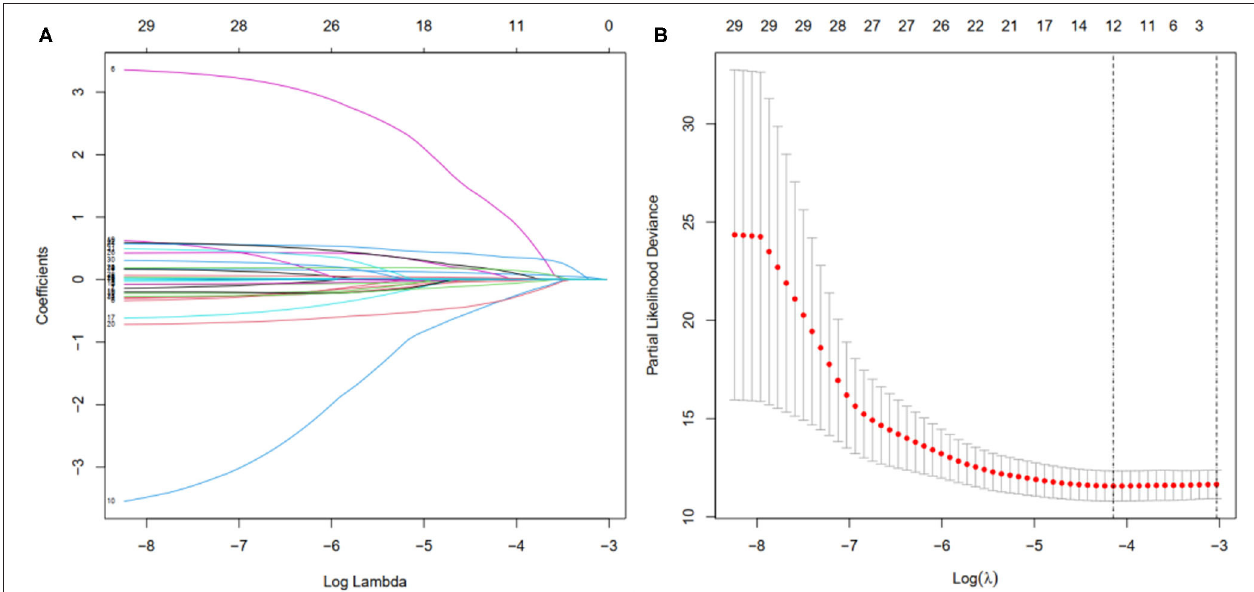
FIGURE 8 | Selection of the optimal survival-related LncRNAs by LASSO Cox regression. (A) LASSO coefficient profiles of the candidate survival-related LncRNAs. A coefficient profile plot was produced against the log λ sequence. (B) Dotted vertical lines were drawn at the optimal values using the minimum criteria.